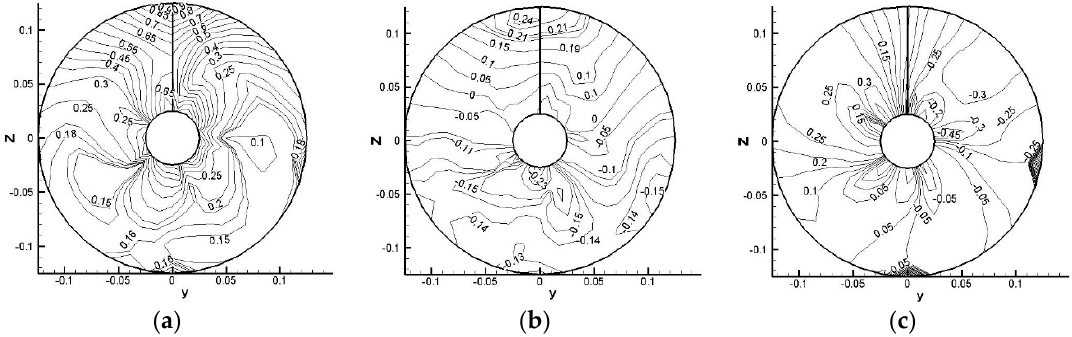
Figure 3. Apparent wake distribution. ( a ) Axial wake distribution; ( b ) Circumferential wake distribution; ( c ) Radial wake distribution.